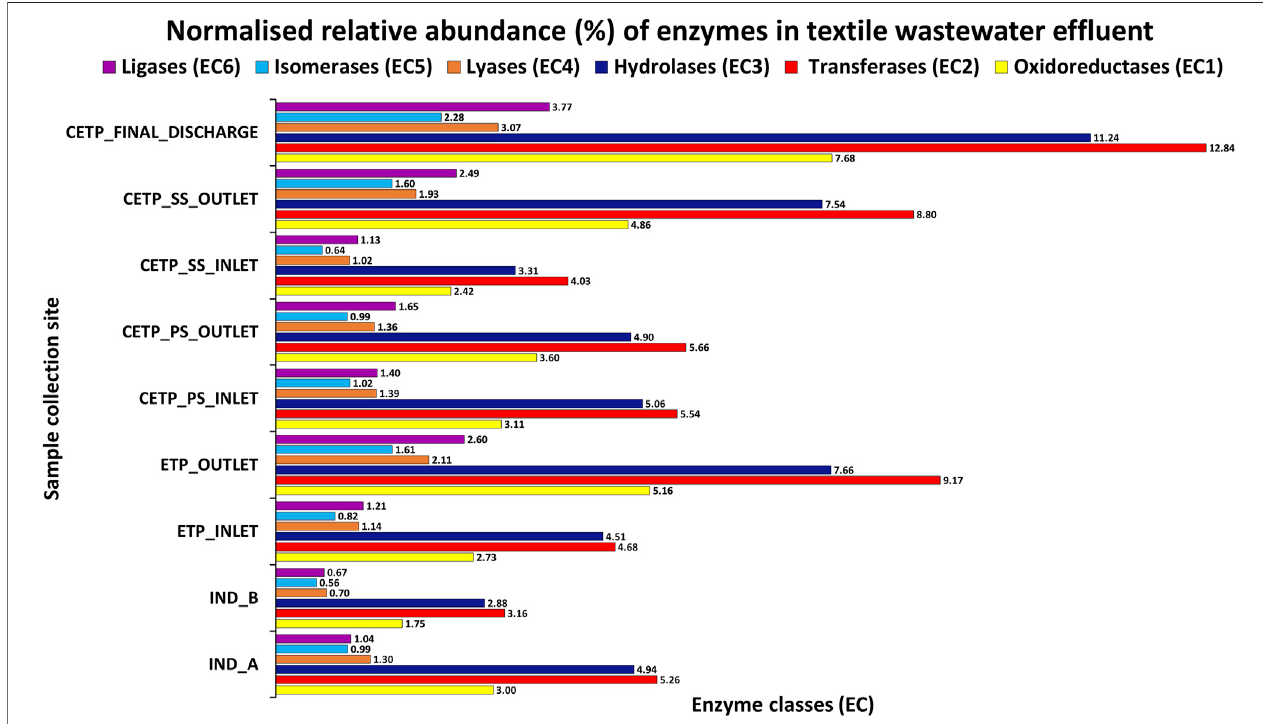
FIGURE6| Readsofthenormalized relativeabundance(%)oftheenzymeclassesgenefamiliesofthedifferentmetagenome samplesfrom textileindustry ef fl uent sites, common ef fl uent treatment plant (CETP), and ef fl uent treatment plant (ETP).